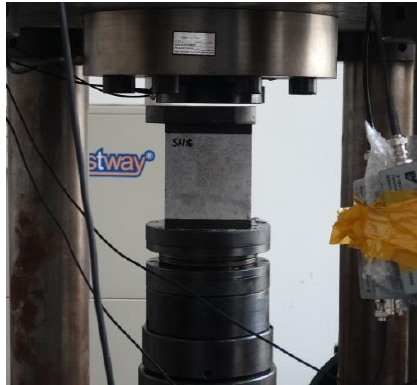
Figure 3. RLJW-2000-type test system.